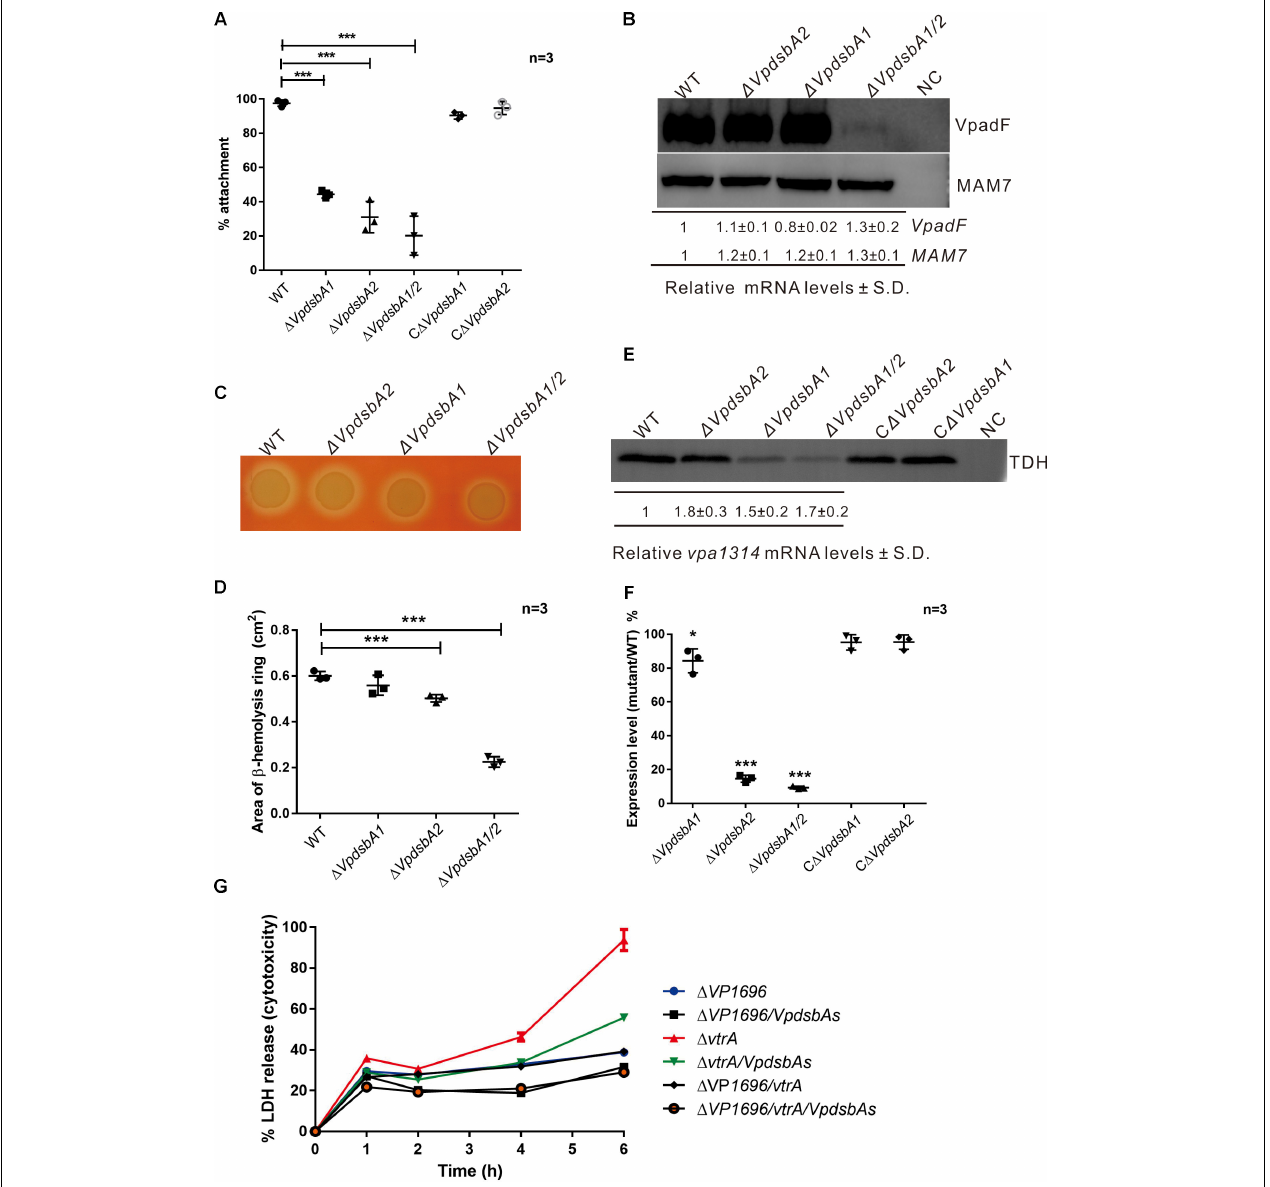
FIGURE 5 | VpDsbAs is required in pathogenesis of V. parahaemolyticus . (A) Adhesion of V. parahaemolyticus WT, (cid:49) VpdsbA1 , (cid:49) VpdsbA2 , and (cid:49) VpdsbA1/2 and the complement strains to Caco-2 cells. Statistical analysis was calculated by one-way ANOVA. n = 3. ∗∗∗ P < 0.001. (B) Top , analysis of VpadF and MAM7 protein levels. V. parahaemolyticus WT, (cid:49) VpdsbA1 , (cid:49) VpdsbA2 , and (cid:49) VpdsbA1/2 containing P BAD -VpadF-cFLAG or P BAD -MAM7-cFLAG were grown in LB-NaCl until OD 600 ≈ 0.8. Cell lysates (1 mg) were separated by SDS-PAGE and VpadF or MAM7 was detected by the Western blot using anti-FLAG monoclonal antibody (Sigma-Aldrich, United States). Blot shown is representative of at least three separate experiments. Bottom , analysis of VpadF and MAM7 mRNA levels by qRT-PCR. RNA was purified from freshly prepared cultures grown in LB-NaCl. The relative mRNA levels ± SD were normalized to 16S RNA. (C) Hemolysis activity of V. parahaemolyticus WT, (cid:49) VpdsbA1 , (cid:49) VpdsbA2, and (cid:49) VpdsbA1/2 strains on Wagatsuma blood agar. (D) Quantification of area of the hemolysis circle of each strain shown in panel (B) was performed using ImageJ software. Statistical analysis was calculated by one-way ANOVA. n = 3. ∗∗∗ P < 0.001. (E) Top , analysis of TDH protein level. V. parahaemolyticus WT, (cid:49) VpdsbA1 , (cid:49) VpdsbA2 , and (cid:49) VpdsbA1/2 and the complement strains were kept growing in LB-NaCl containing 1 mM of taurodeoxycholate acid (TDCA) at 37 ◦ C until 10% (vol/vol) trichloroacetic acid (TCA) was added. Protein samples were suspended in a buffered solution containing 100 mM Tris-HCl pH 7.5 and 1% (wt/vol) SDS and 1 mg of each sample was separated by SDS-PAGE and TDH was detected by the Western blot using anti-TDH antibody. Blot shown is representative of at least three separate experiments. Bottom , analysis of vpa1314 mRNA levels by qRT-PCR. RNA was purified from freshly prepared cultures grown in LB-NaCl containing 1 mM of TDCA. The relative mRNA levels ± SD were normalized to 16S RNA compared with that of WT. (F) Quantification of band intensities from blot shown in panel (E) was performed using ImageJ software. Graph represents percentages of TDH compared with that of WT. Protein expression levels were normalized to that of WT. Data shown are averages of three independent experiments. Statistical analysis was calculated by one-way ANOVA. n = 3. ∗ P < 0.05, ∗∗∗ P < 0.001. (G) Cytotoxicity assay of V. parahaemolyticus mutant strains against HeLa cells by detecting the release of LDH into the medium at each indicated time. Parameters reported include the mean ± SD across three